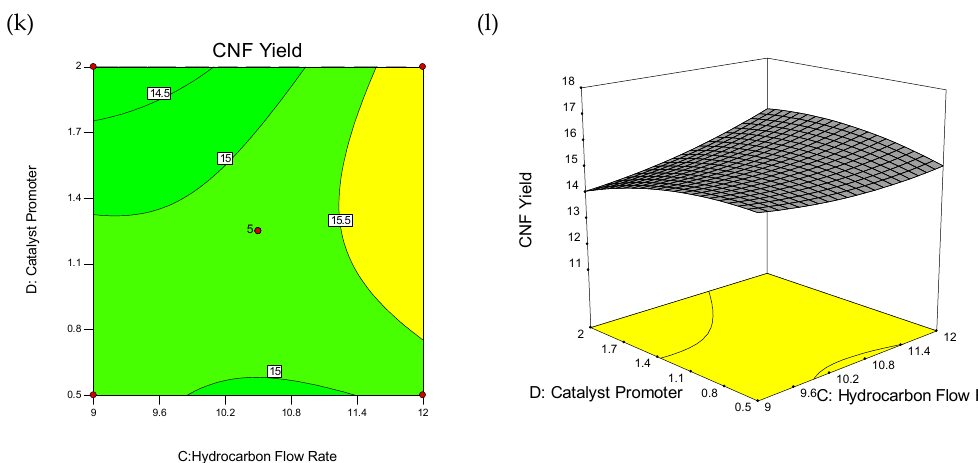
Figure 2. 3D wireframe surface plot and contour plot: Interaction effect of factors on carbon nanofiber (CNF) yield (%). Contour Plot of Interactions between Temperature and Catalyst Weight ( a ), Temperature and Hydrocarbon Flow Rate ( c ), Temperature and Catalyst Promoter Concentration ( e ), Hydrocarbon Flow Rate and Catalyst Weight ( g ), Catalyst Promoter Concentration and catalyst weight ( i ), Catalyst Promoter Concentration and Hydrocarbon Flow Rate ( k ), and 3D Wireframe Surface Plot of the Interactions between Temperature and Catalyst Weight ( b ), Temperature and Hydrocarbon Flow Rate ( d ), Temperature and Catalyst Promoter Concentration ( f ), Hydrocarbon Flow Rate and Catalyst Weight ( h ), Catalyst Promoter Concentration and Catalyst Weight ( j ), Catalyst Promoter Concentration and Hydrocarbon Flow Rate ( l ) on Yield of CNF. As demonstrated in Figure 3, the virtual model was highly in accordance with the obtained experimental results, indicated by its high R 2 value (R 2 = 0.911).